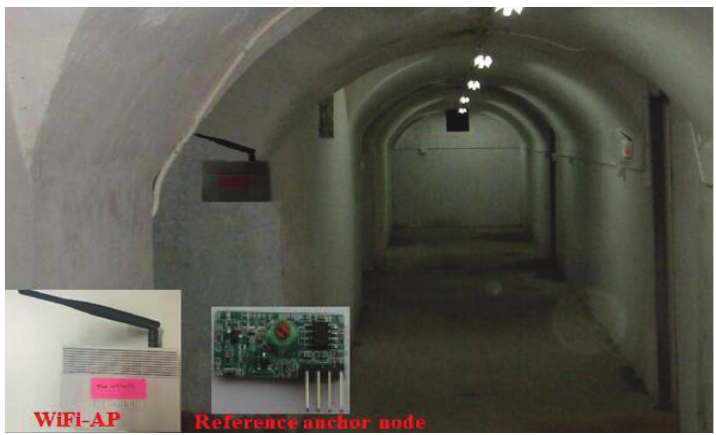
Figure 7. Experimental